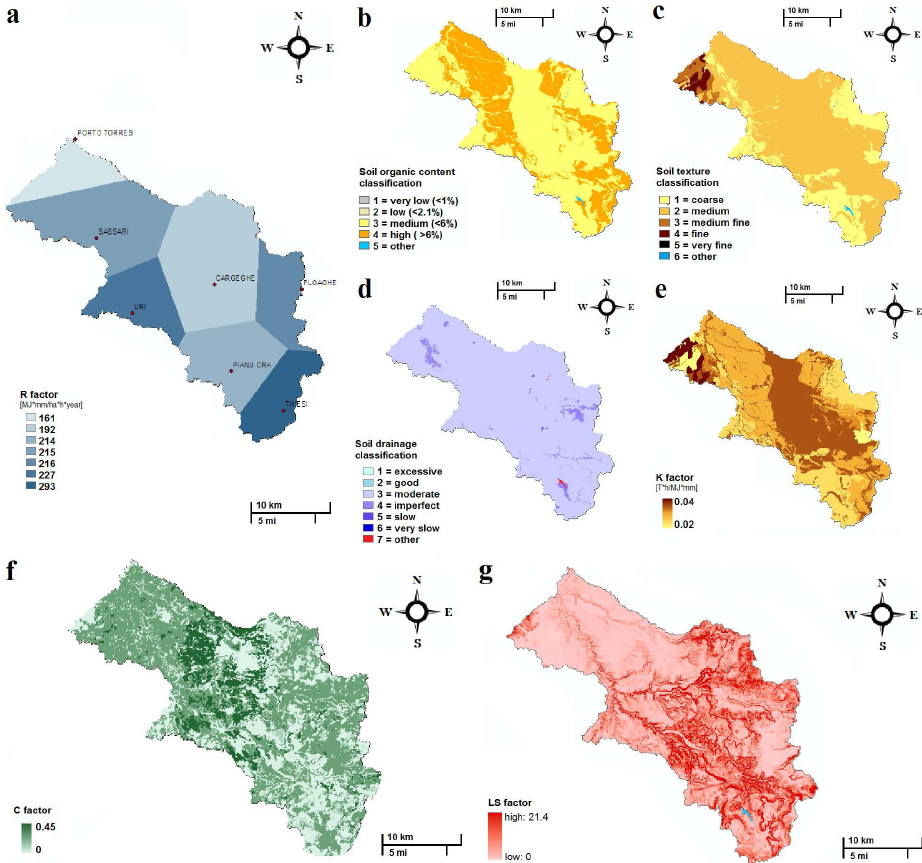
Fig. 2. (a) Spatially distributed RUSLE erosivity factor; (b–d) soil organic content classification, soil texture classification, soil drainage classification; (e) RUSLE soil erodibility factor, RUSLE soil cover and management factor; (g) RUSLE slope length and steepness factor.